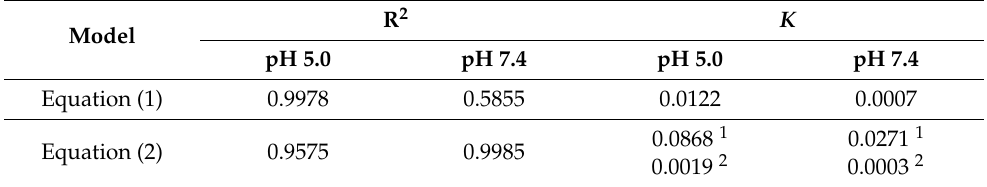
Table 1. Kinetic parameters for DOXO release profiles from DOXO@DEX/CUR at pH 5.0 and